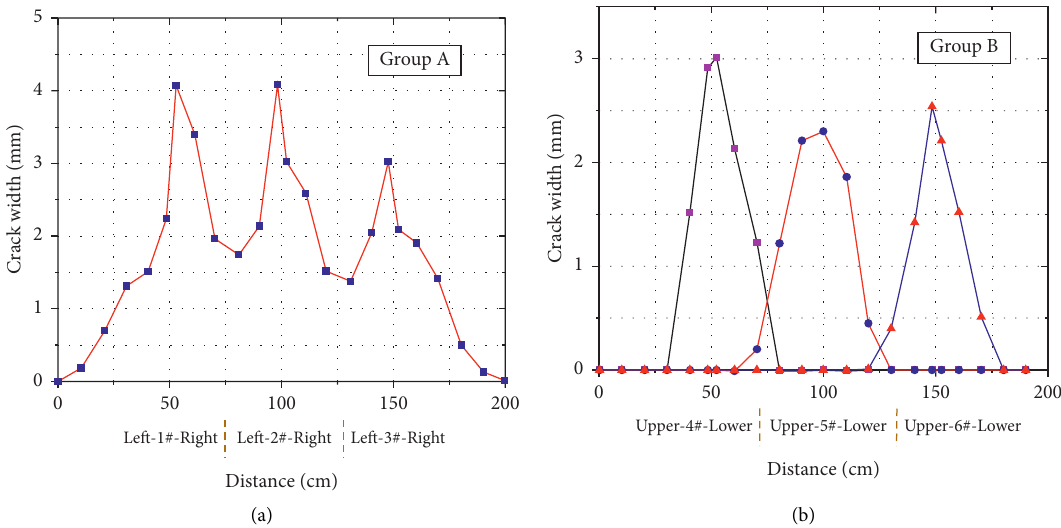
Figure 6: Crack width at different distances from the gun hole along the direction of energy concentration. (a) Group A. (b) Group